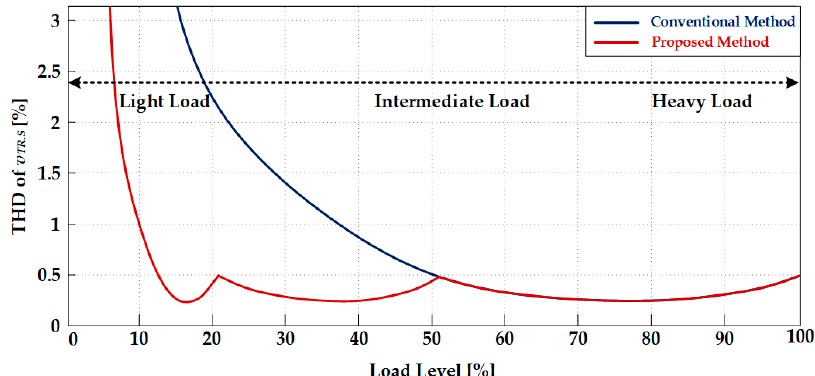
Figure 3. Comparison of operating areas according to the control methods.